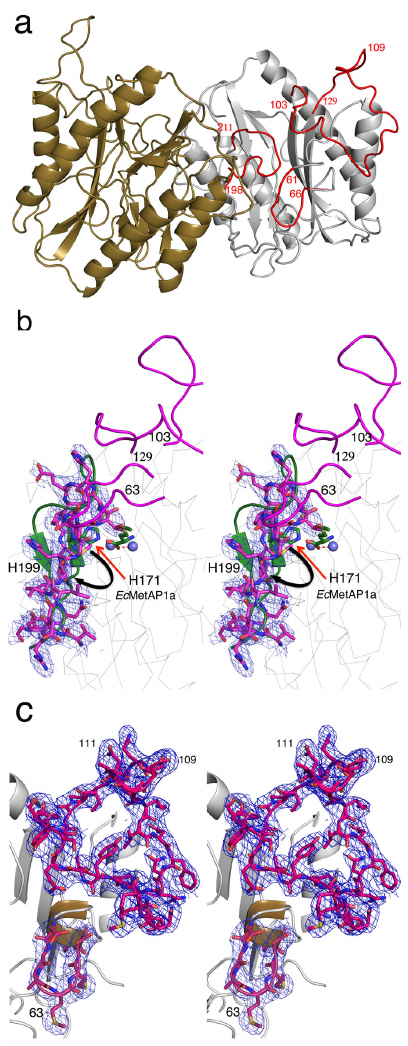
Figure 3. Crystal structure of Sp MetAP1a. a)